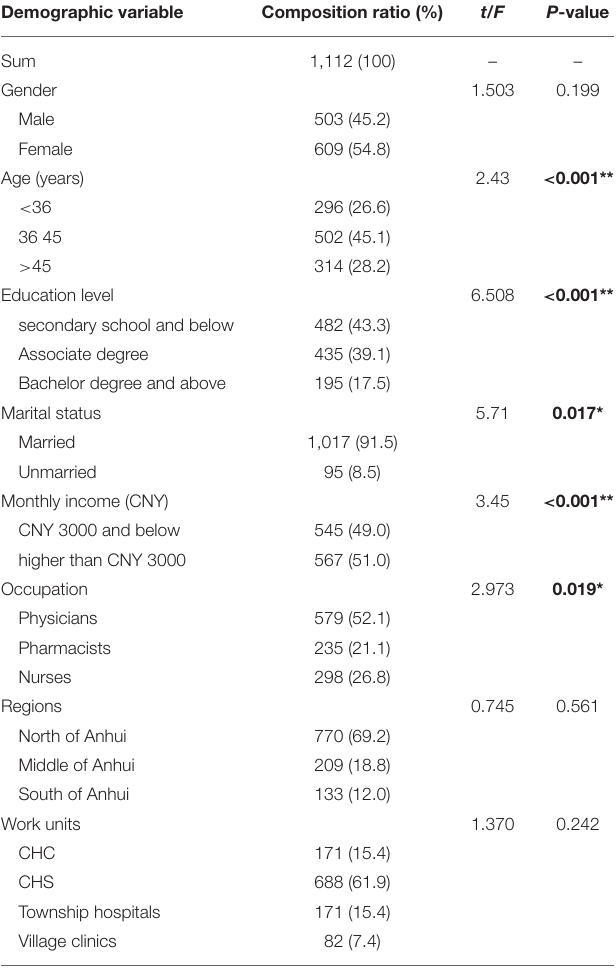
TABLE 1 | Socio-demographic characteristics of participants ( n =